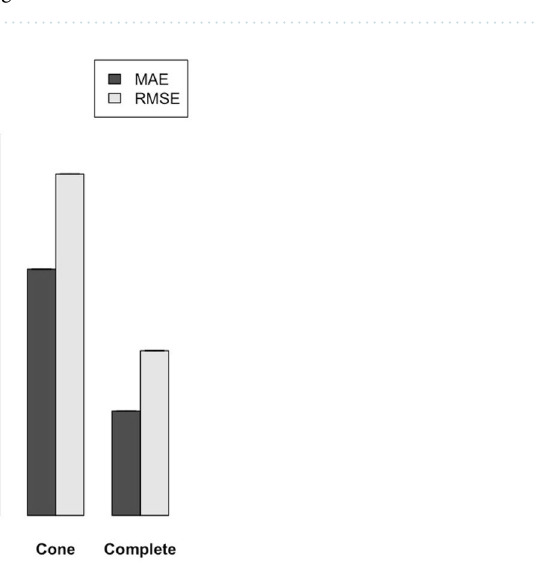
Figure 5. Property landscapes of atomic radius (Rahm et al. 27 ), electron negativity, melting point, and thermal conductivity at 25 ℃ that are embedded in the latent spaces. The heatmaps are laid on ( a ) the square table in Fig. 2 and ( b ) the conical table (top view) in Fig. 3.